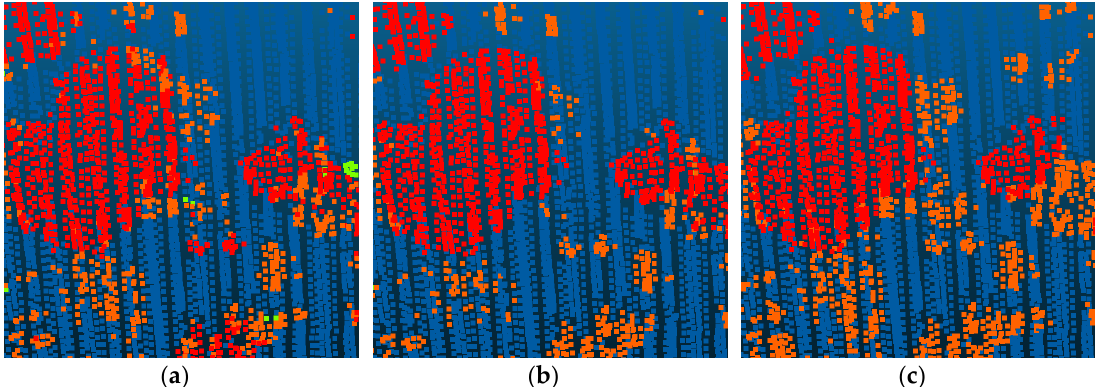
Figure 10. The detailed improvement of roof and tree classification. ( a ) The Point_S result. ( b ) The SegT_M result. ( c ) The ground truth.